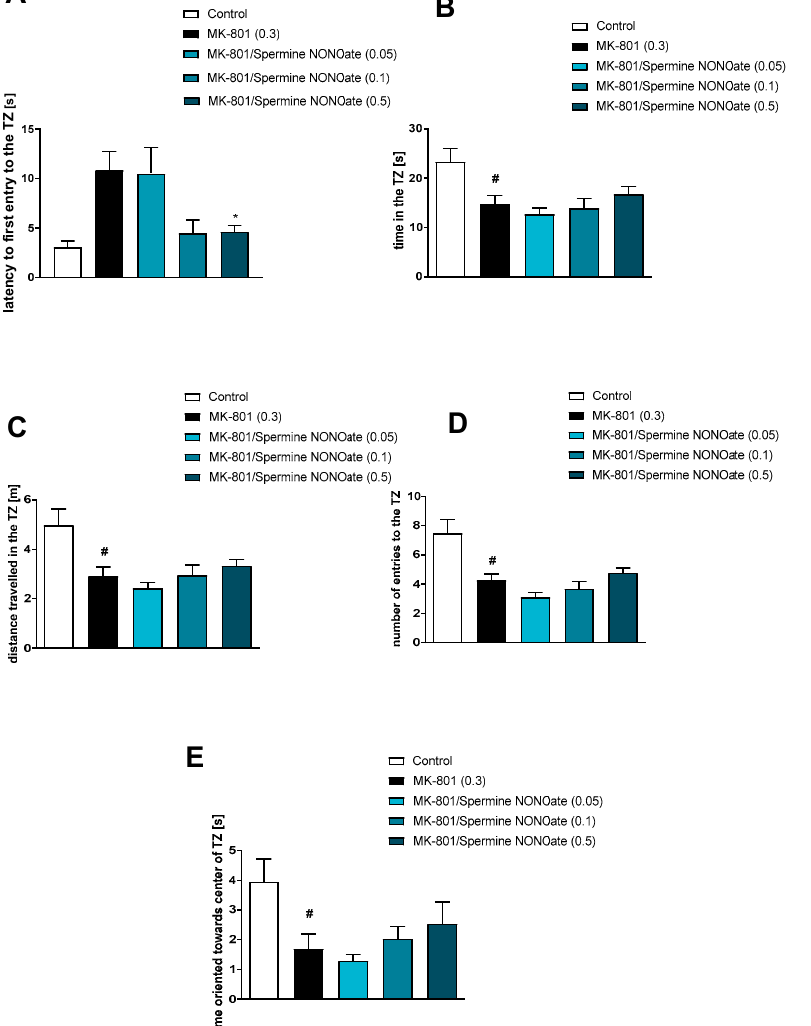
Figure 8. The effects of spermine NONOate on MK-801-induced deficits in the retention of spatial memory in the MWM of CD1 mice. TZ-related parameters. ( A ) the latency to the first entry into the TZ, ( B ) the time in the TZ, ( C ) the distance travelled in the TZ, ( D ) the number of entries into the TZ, and ( E ) the time oriented towards the centre of the TZ when inside the zone. The values are expressed as the means ± SEM. # p < 0.001 vs. control group and * p < 0.05 vs. scopolamine-treated animals (N = 8–10).